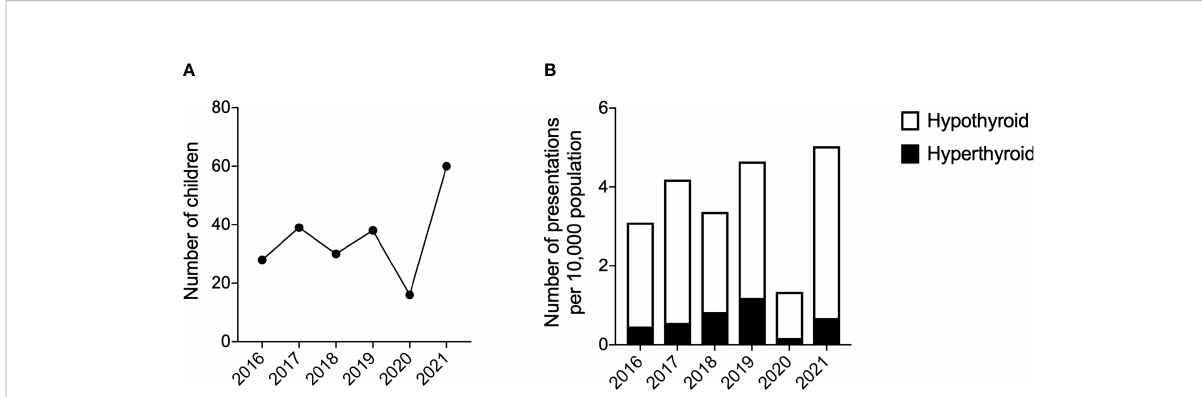
FIGURE 2 Number of presentations with thyroid dysfunction. (A) Number of children presenting with thyroid dysfunction per year. (B) Number of presentations of hyperthyroidism and hypothyroidism per 10,000 population. Years 2016-2019 used the mid-2016 population estimate for